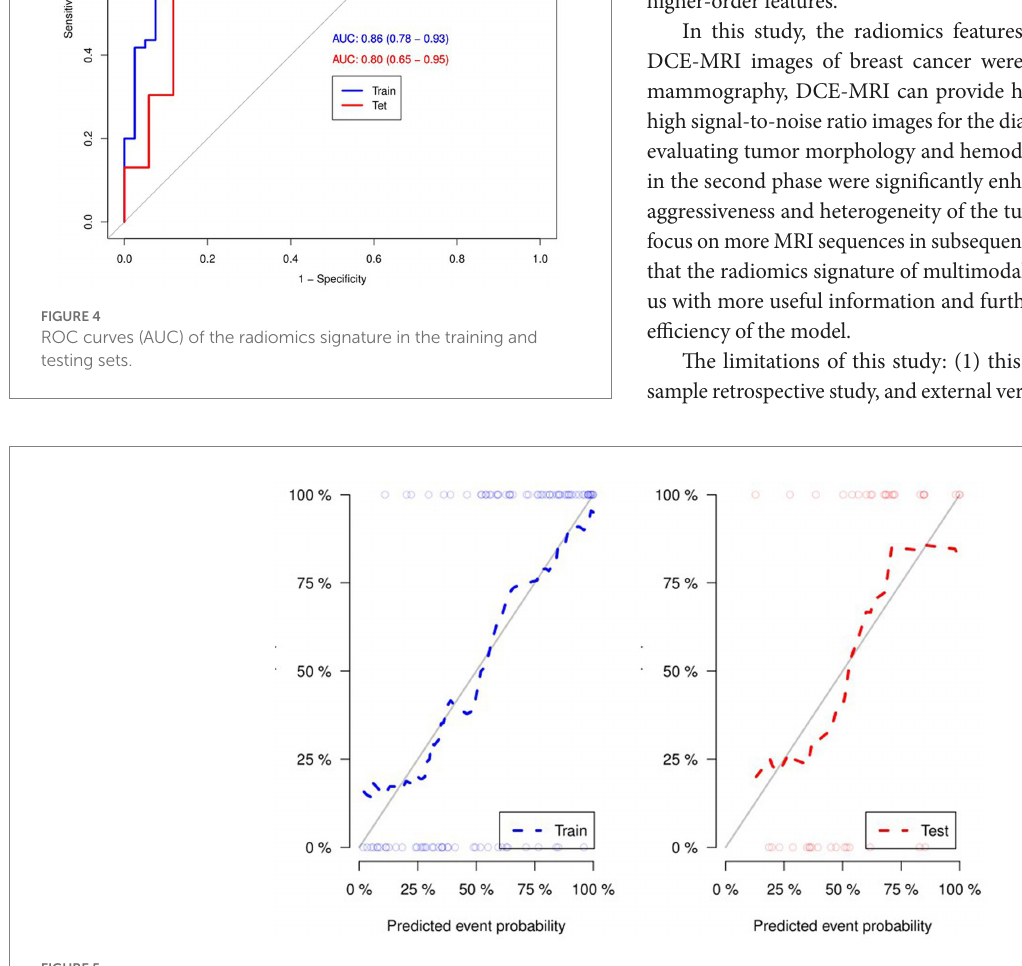
FIGURE 5 For the calibration curve of the radiomics signature, the closer the fit between the two curves, the higher the prediction accuracy.